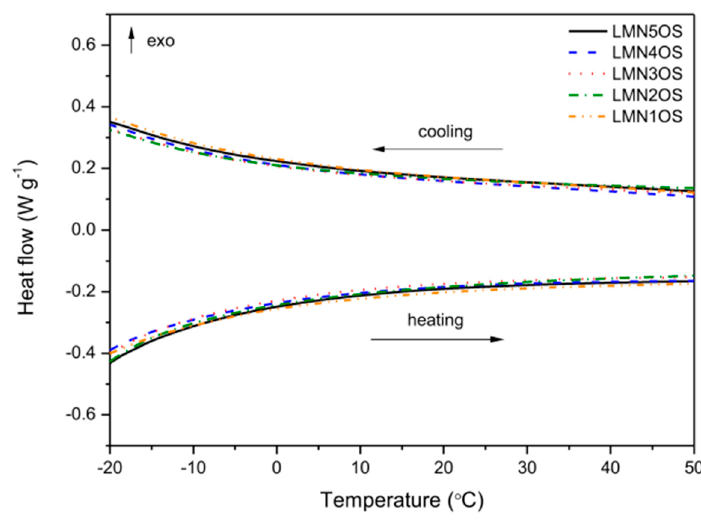
Figure 4. Differential scanning calorimetry results of Ni and S doped LiMn 2 O 4 materials calcined at 650 °C.